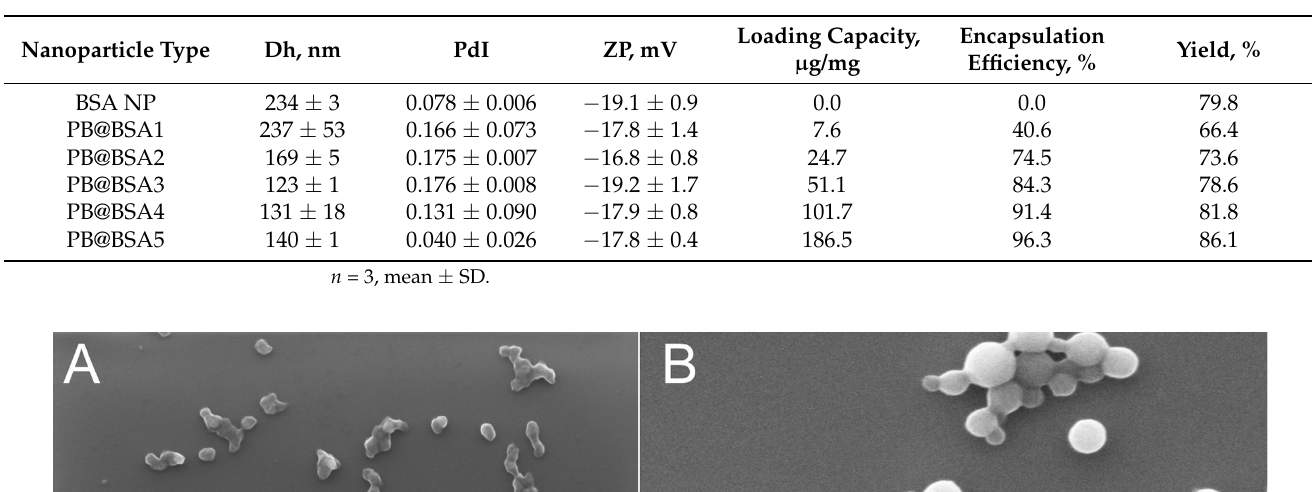
Table 1. Properties of PB@BSA nanoparticles.